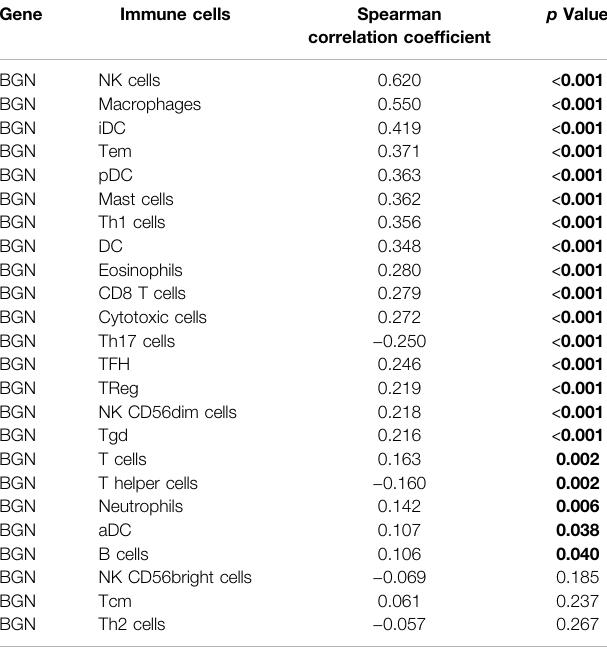
Bold indicates statistically signi fi cant, that is, a p value less than 0.05.